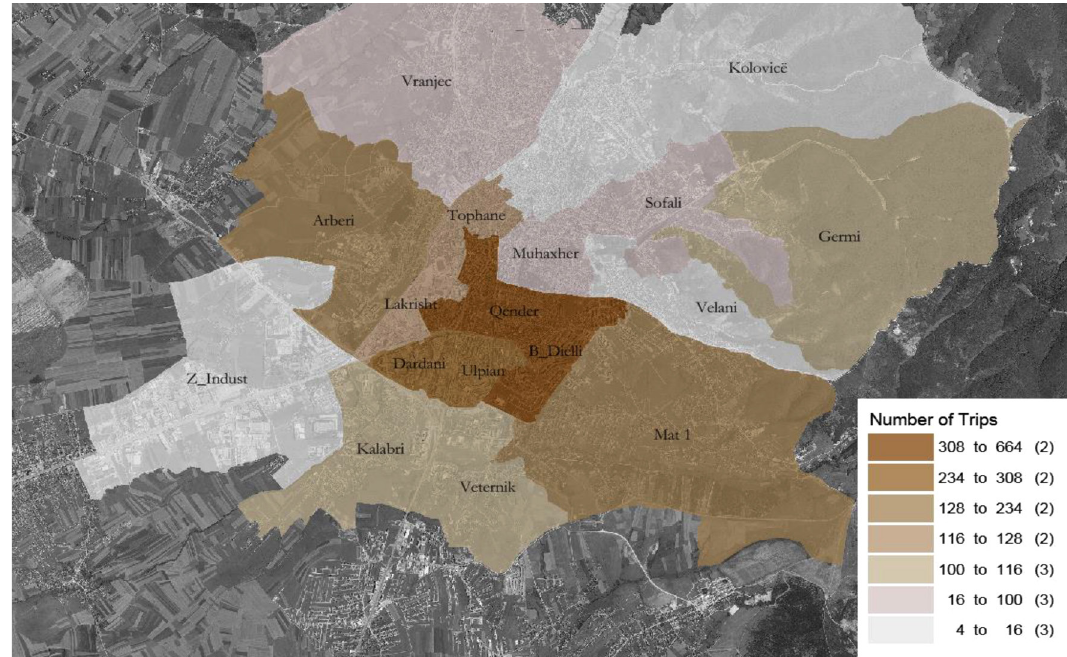
Fig. 1. Number of trips in the Pristina city centre